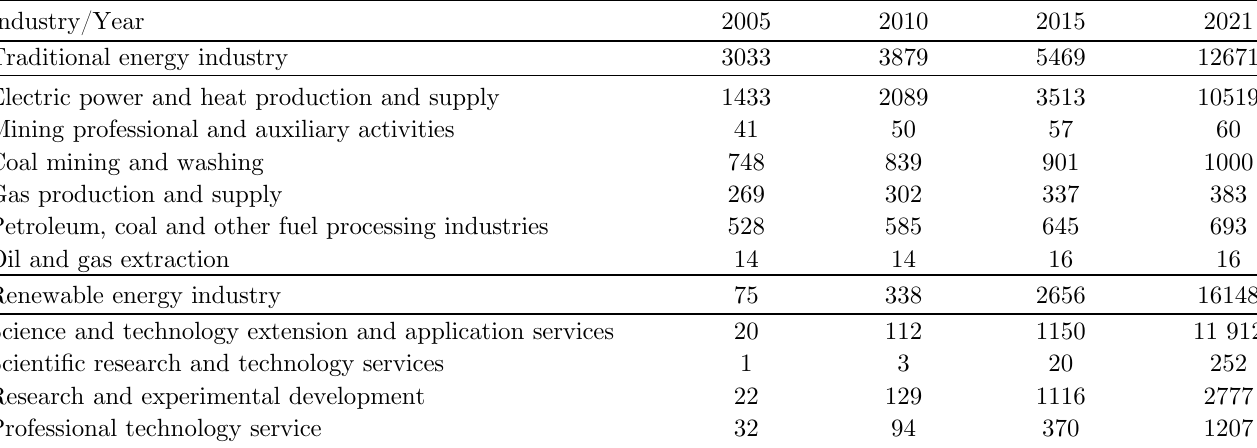
Table 1. Classi fi cation of traditional energy and renewable energy industries in Hebei province.